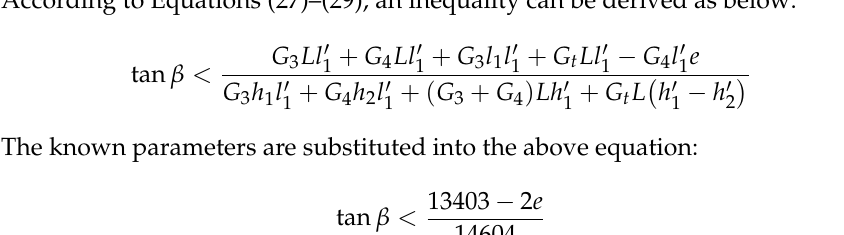
Figure 6. Partial force schematic of the triangular track when climbing up.